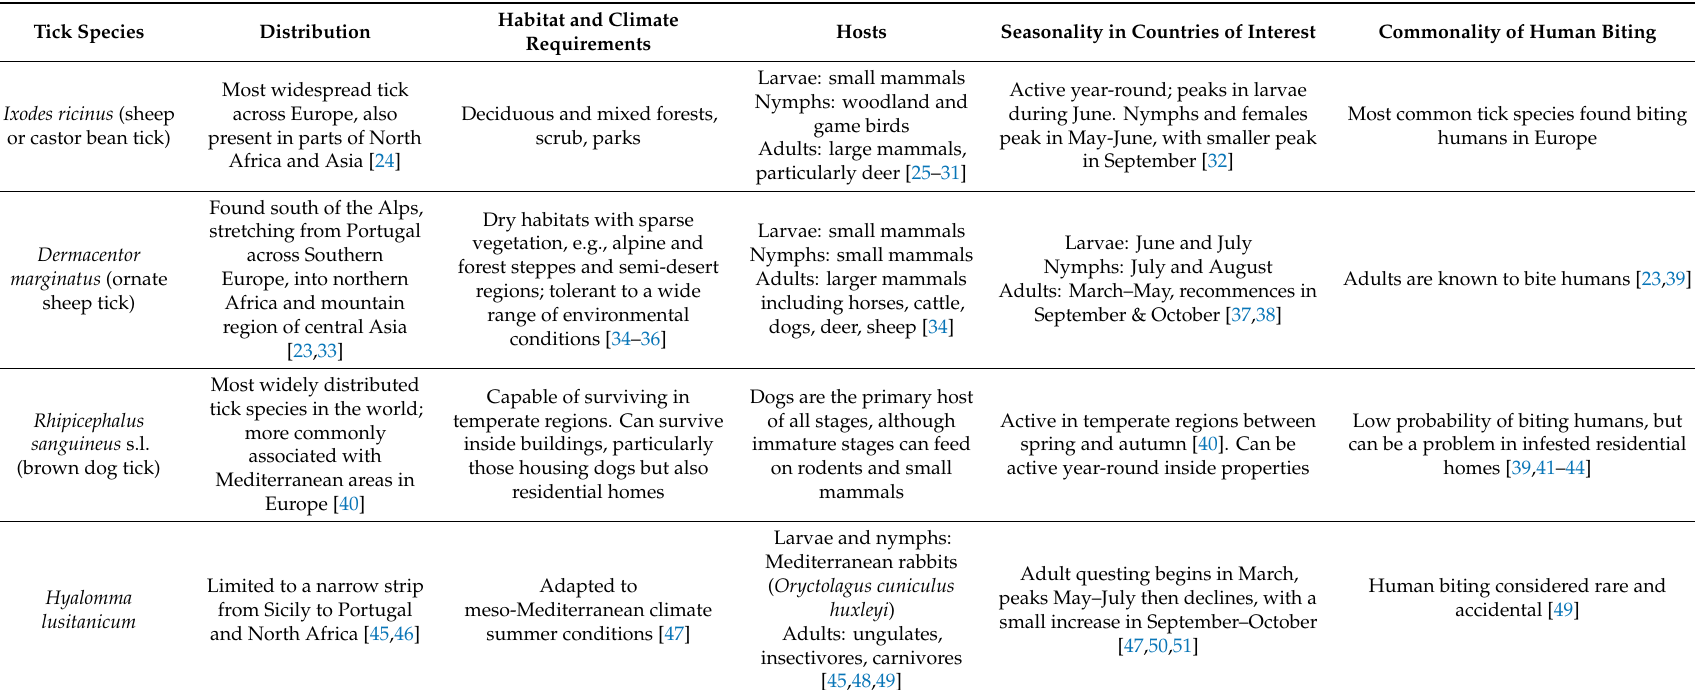
Table 2. Review of distribution, habitat and climate requirements, hosts, seasonality and commonality of human biting of each confirmed and possible imported tick species, along with the prevalence of the most common human pathogens detected in the focal tick species in the country where the tick was confirmed or suspected to have been acquired. References are mostly focused on countries listed in the history of travel, but literature searches were extended if there was no information available for the tick species in the